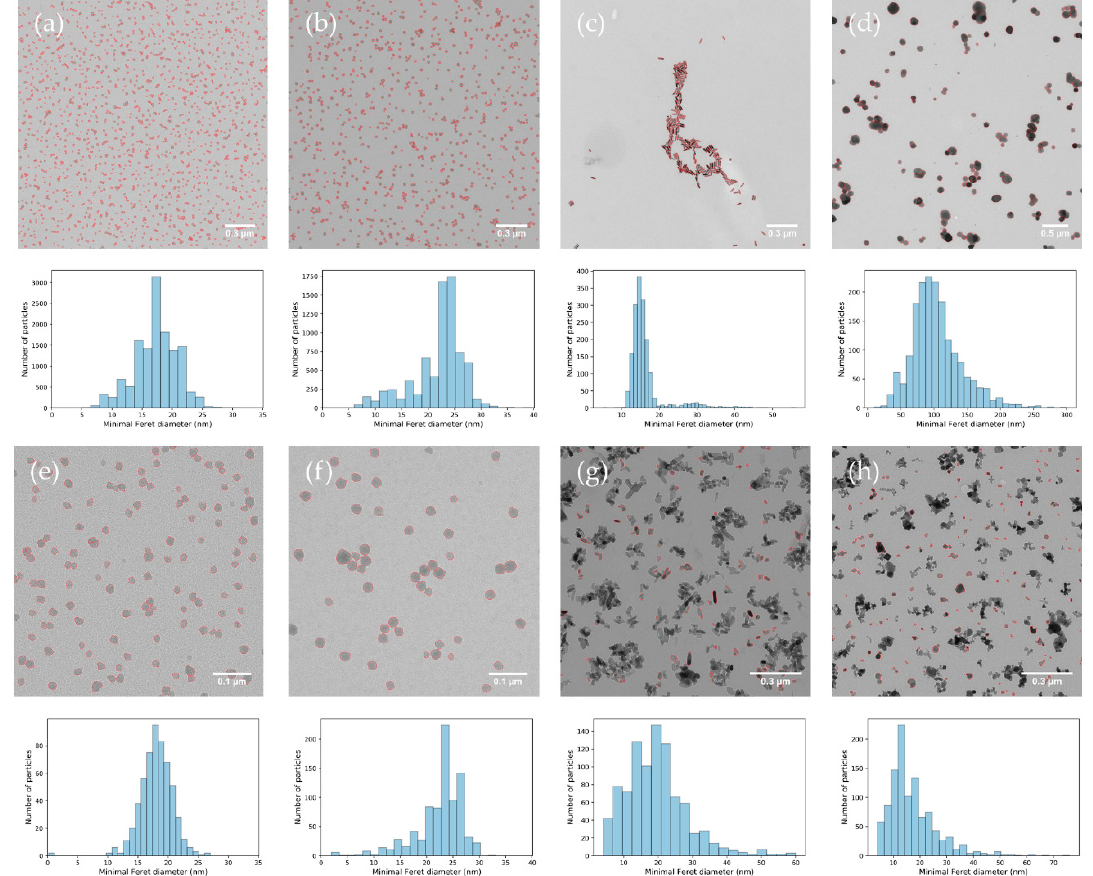
Figure 3. Annotated transmission electron microscopy (TEM) images analysed by the ParticleSizer software and corresponding particle size distributions (of 1 set of 10 images) for ( a ) ERM-FD100 18,500 × , ( b ) ERM-FD304 18,500 × , ( c ) Gold nanorods, ( d ) NM-100, ( e ) ERM-FD100 68,000 × , ( f ) ERM-FD304 68,000 × , ( g ) NM-103, and ( h ) NM-212.